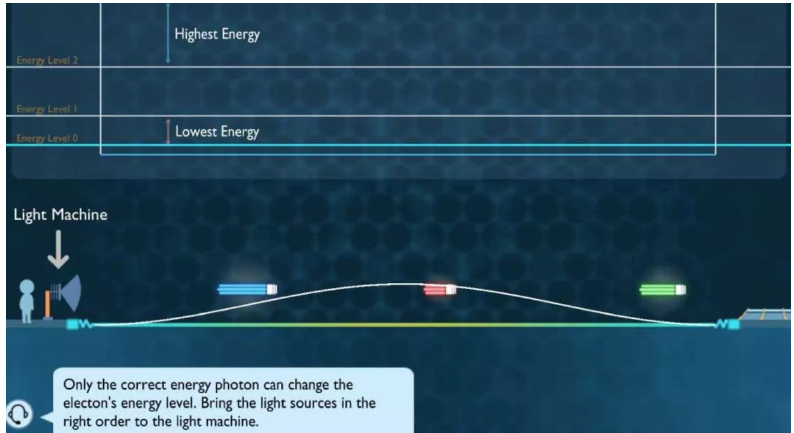
Figure 2. Particle in a box is a video game exploring the very first differences between classical physics and quantum physics, developed by an interdisciplinary team at Georgia Institute of Technology (Atlanta, GA, USA).